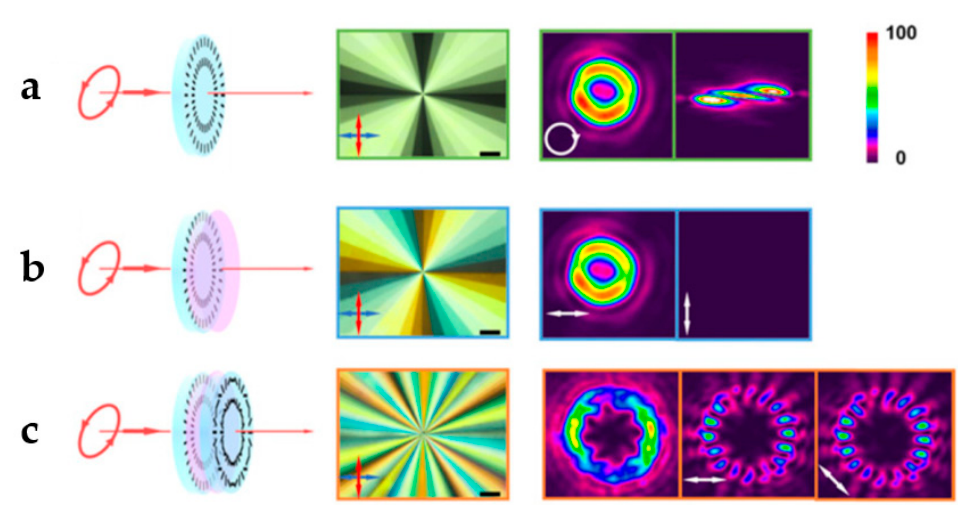
Figure 4. Micrographs and the output beam patterns: ( a ) q-plate 1, ( b ) after stacking a LCP quarter-wave plate (QWP), ( c ) overlaying all desired films. Short black lines on blue plates indicate liquid crystal (LC) director distribution in the q-plate; pink plates illustrate a QWP. Polarizer directions are indicated by red and blue arrows. White arrows show the direction of analyzer before the charge-coupled device. Scale bars and color bar indicate 200 µ m and relative optical intensity, respectively [34].